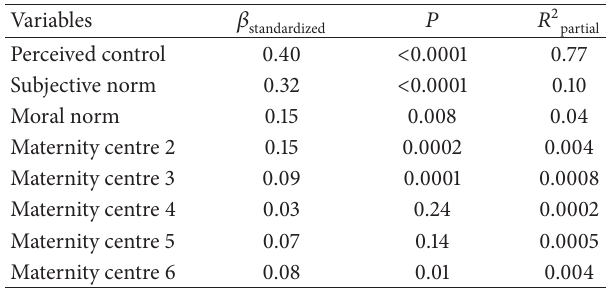
Table 4: Final explicative